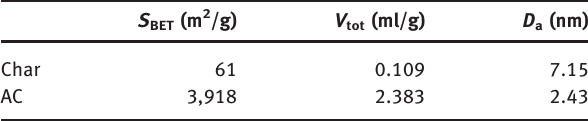
Table 8: Comparison of pore structures of AC prepared from various waste matter by KOH activation. Precursor